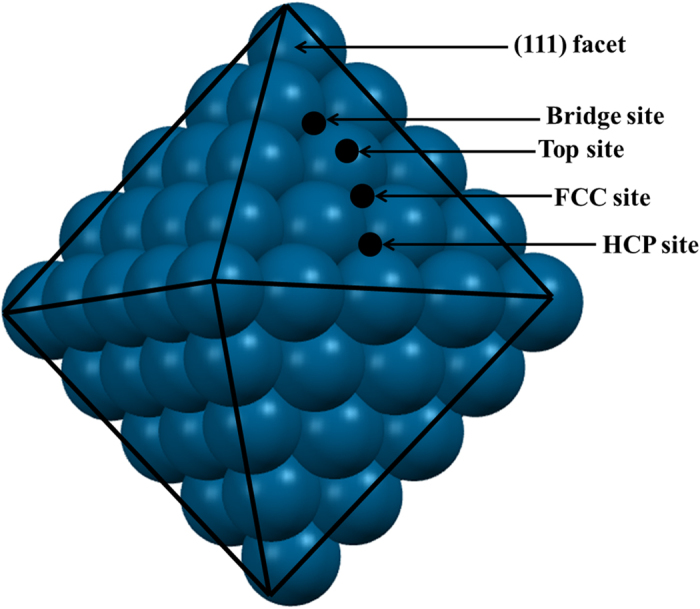
Octahedral Ni85 nanocluster enclosed by eight (111) facets.